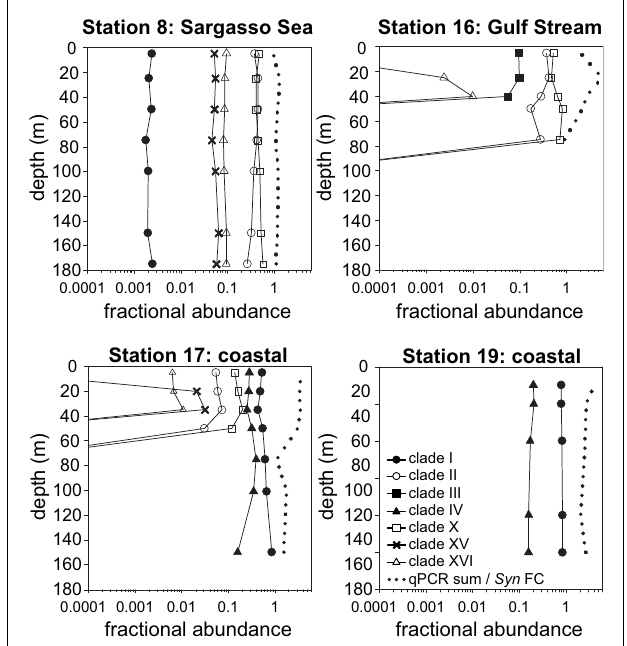
FIGURE 6 | Relative abundances of Synechococcus clades and the ratio of summed abundances to total Synechococcus abundance determined by flow cytometry. Relative abundances of clades were calculated by dividing the abundance of each clade by the sum of all clades detected by qPCR. Dotted lines depict the ratios of summed qPCR abundances to total Synechococcus abundances determined by flow cytometry (qPCR sum/ Syn